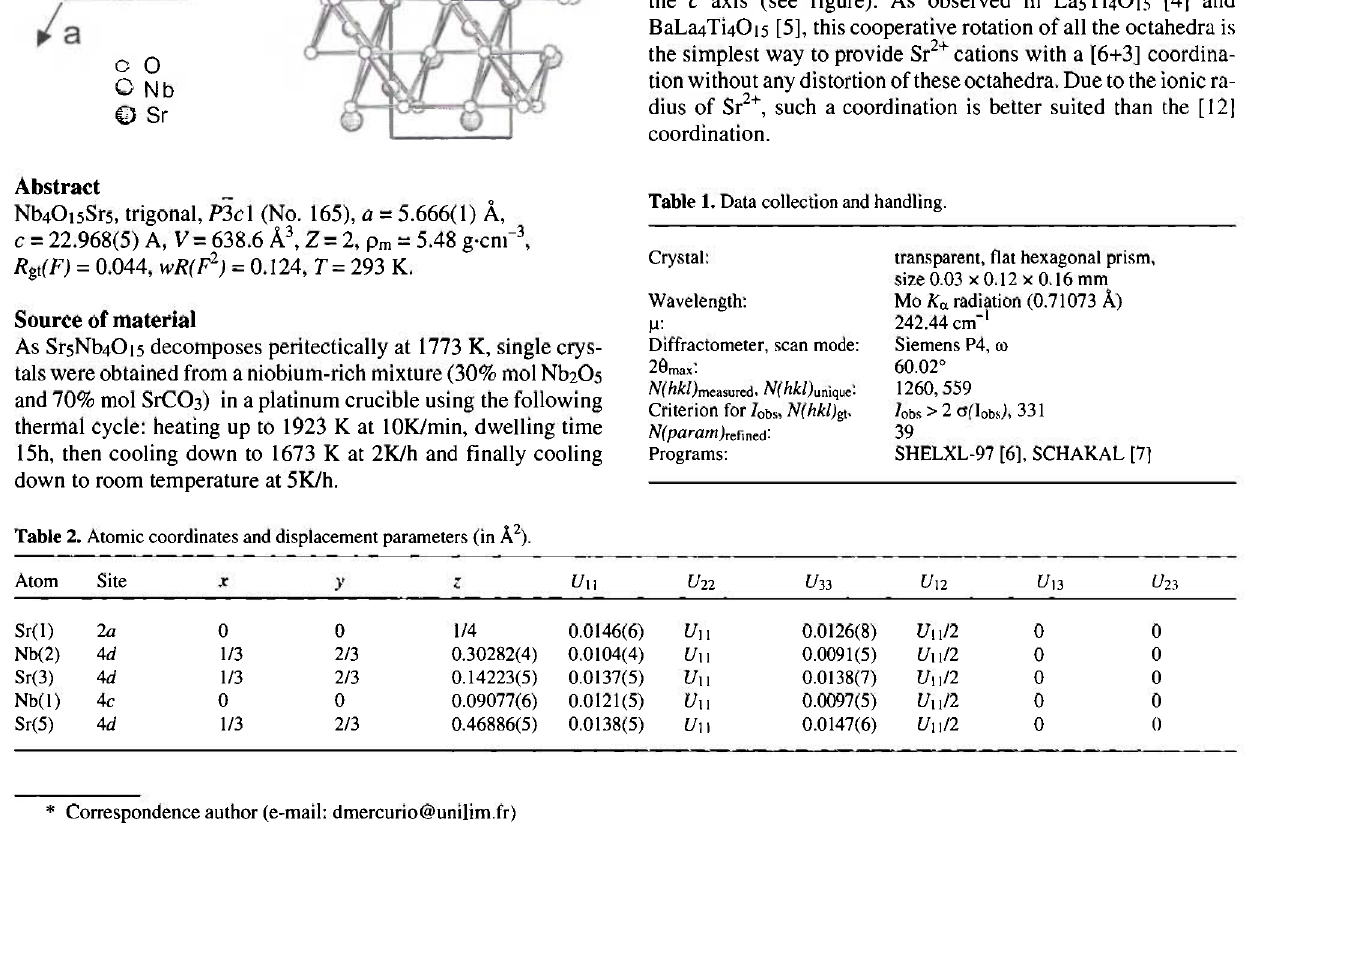
Table 1. Data collection and handling.